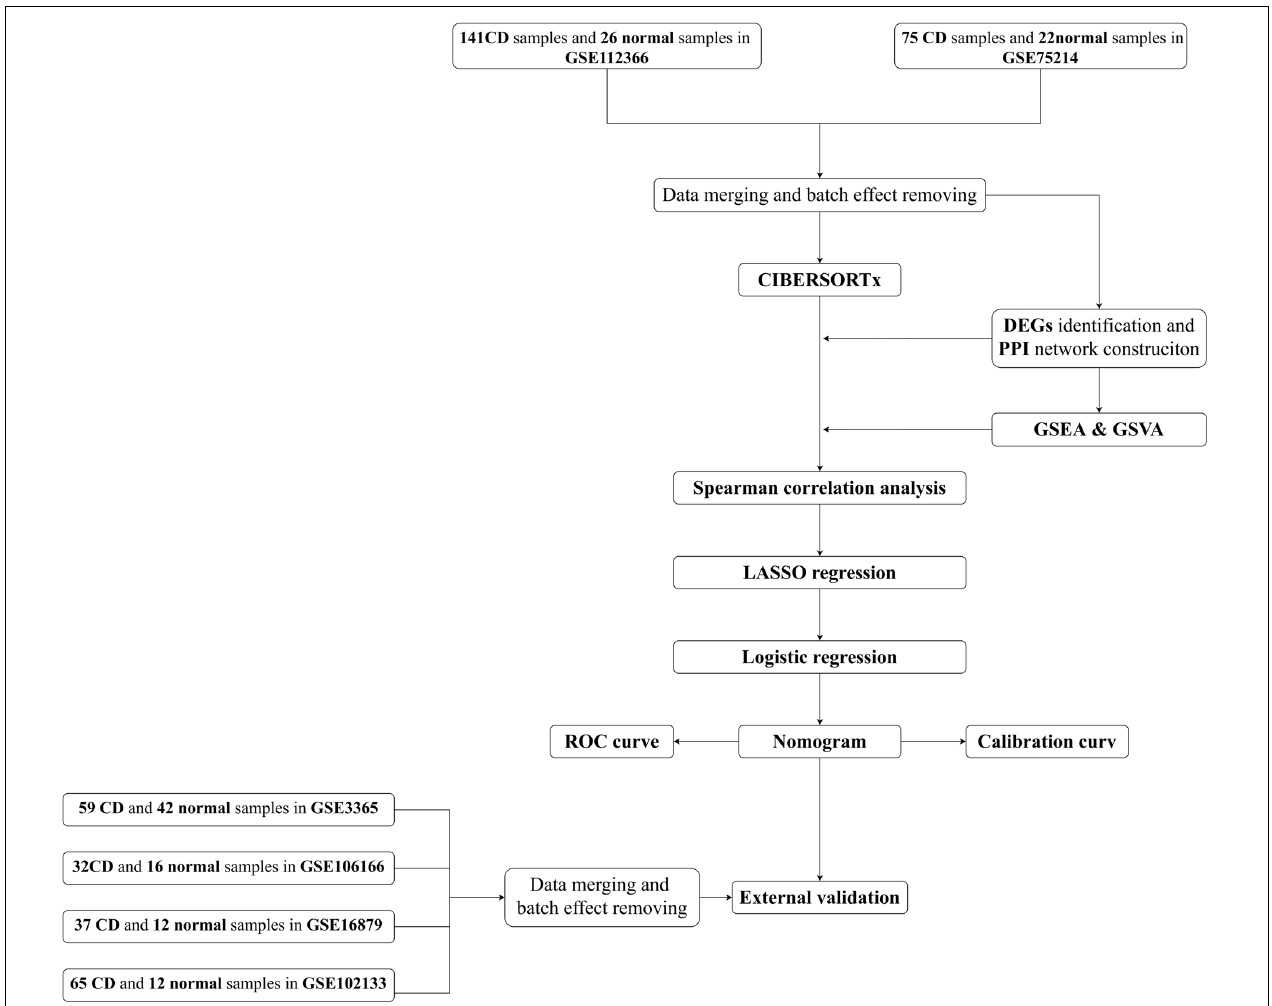
FIGURE 1 | Flow chart of the analyses used in this